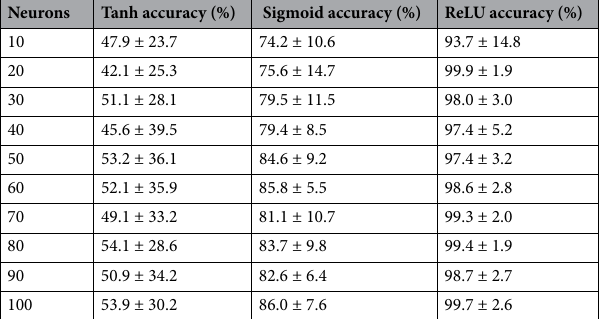
Table 2. Performance of FFNN with one hidden layer and Tanh, Sigmoid, and ReLU as activation functions with different neurons.